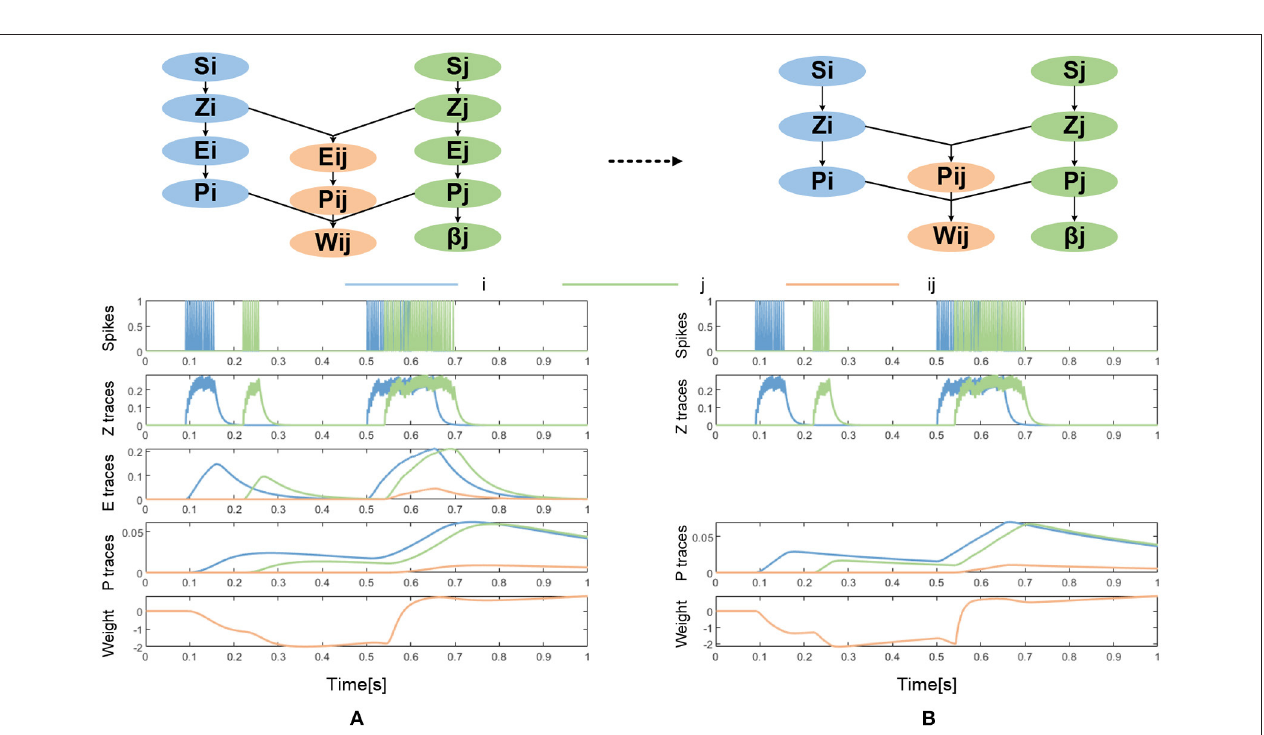
implemented as custom hardware with 3D integration of DRAM for the synaptic weights (Farahini et al., 2014; Lansner et al., 2014; Stathis et al., 2020; Yang et al., 2020). The BCPNN learning